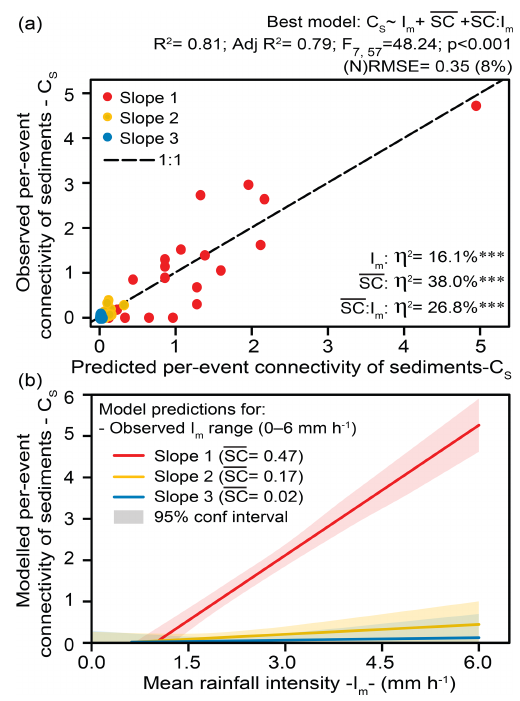
Figure 6. Structural and dynamic control of patch-scale to hillslope- scale sediment connectivity: (a) best-supported model of sediment connectivity and corresponding observed-versus-predicted sedi- ment connectivity values; (b) modelled I m and SC effects on runoff connectivity. The structure, R 2 , Adj R 2 , F statistic, p value and (normalized) root-mean-squared error of the best-supported model are detailed on top of the graph; η 2 values within the graph indicate the percent variance explained by the direct and interaction terms of the model. Significance: ∗∗∗ p < 0 . 001; ∗∗ p < 0 . 01; ∗ p < 0 . 05; “ns” not significant at α = 0 .